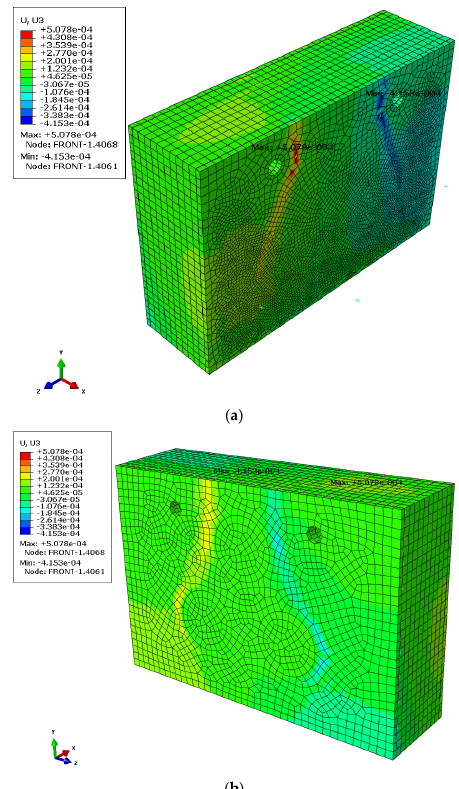
Figure 19. Concrete + steel displacements (U, U3) for ( a ) reaction (front) side and ( b ) forcing (rear) side.